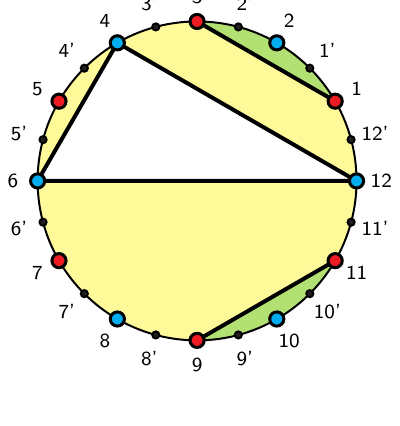
Figure 5: Kreweras